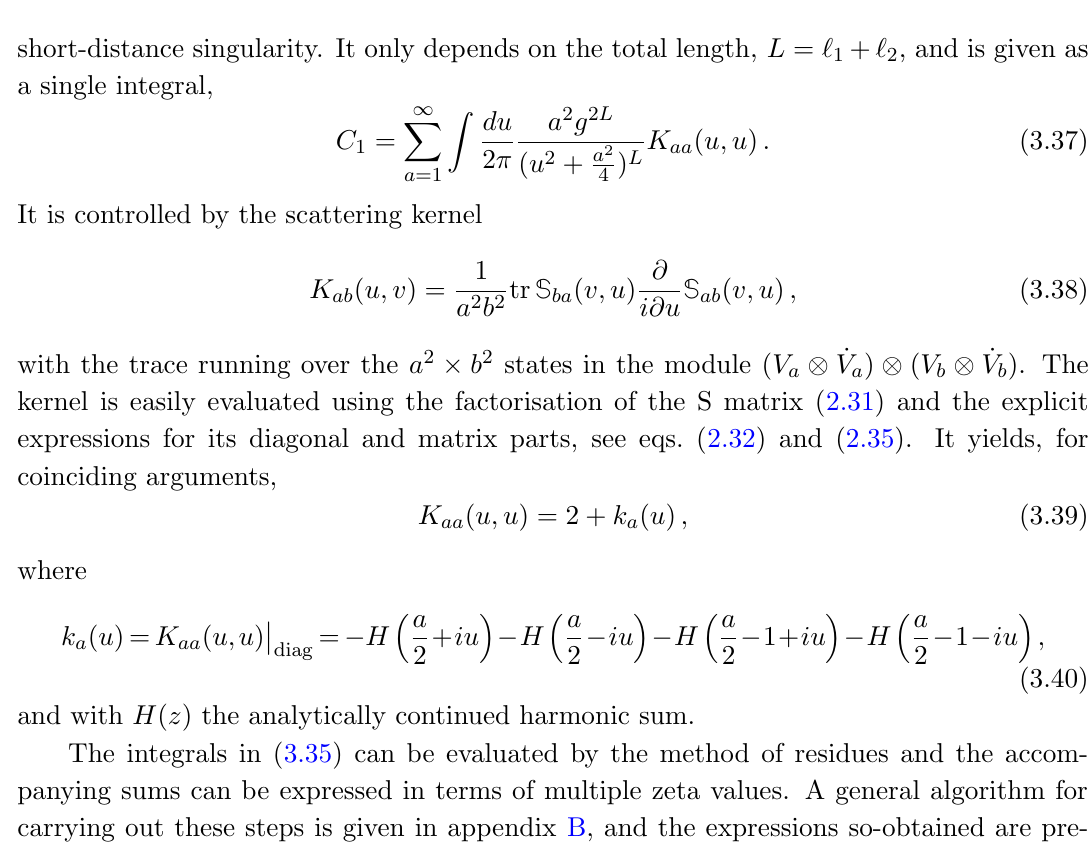
Table 1 . for various bridge lengths, ‘ 2 and ‘ 3 , up to the overall factor of the coupling, A 1-wheel g 2( ‘ 2 + ‘ 3 ) . The method used for generating these expressions is described in appendix